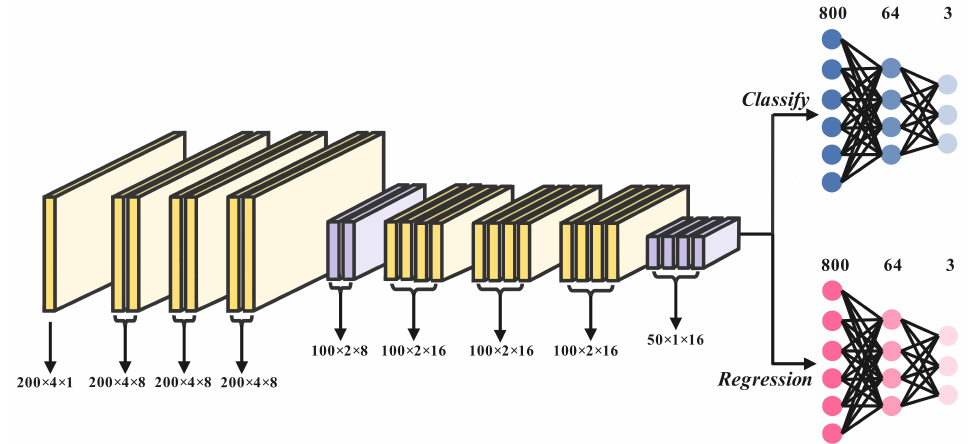
Figure 4. The HMID-NET structure. The rectangles represent the convolutional layer plus the activation function, the yellow represents the convolutional layer, the purple represents the pooling layer, and the circles represent the